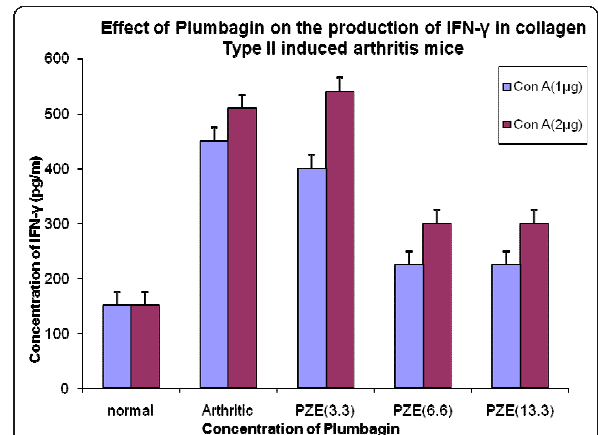
Figure 6 Effect of Plumbagin on the production of IFN- g in collagen Type II induced arthritis mice . Four groups of DBA/1 mice were immunized with 0.1 ml of bovine type II collagen intradermally at the base of the tail. Booster dose was given 3 weeks after primary immunization. Normal group did not receive any injection. Test groups were treated intraperitoneally with Plumbagin (3.3 mg/kg), (6.6 mg/kg) and (13.3 mg/kg) respectively. Control group was treated with vehicle alone. At the end of the experiment, mice were sacrificed and Spleenic T lymphocytes isolated from arthritic mice, Plumbagin treated mice and normal mice were incubated with 1 μ g and 2 μ g of Con A and maintained the conditions similar to the previous culture experiments. Cultures supernatants were collected and IFN- g production was estimated by ELISA. p-value ≤ 0.05 was